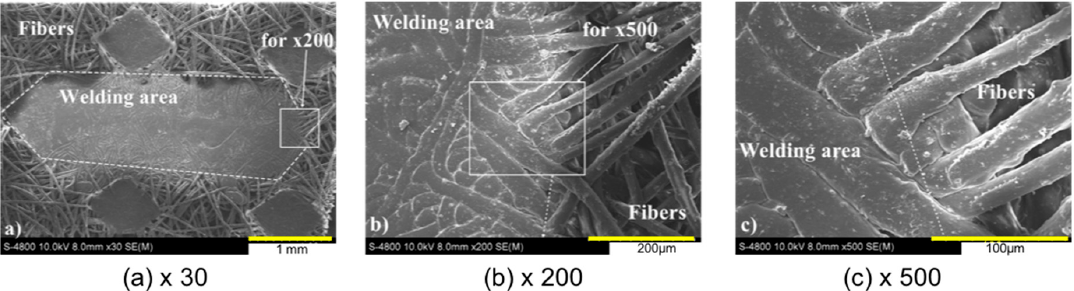
Figure 9. SEM images of the ultrasonic welding joints taken from the backside with magnification of ( a ) × 30, ( b ) × 200, and ( c ) × 500.